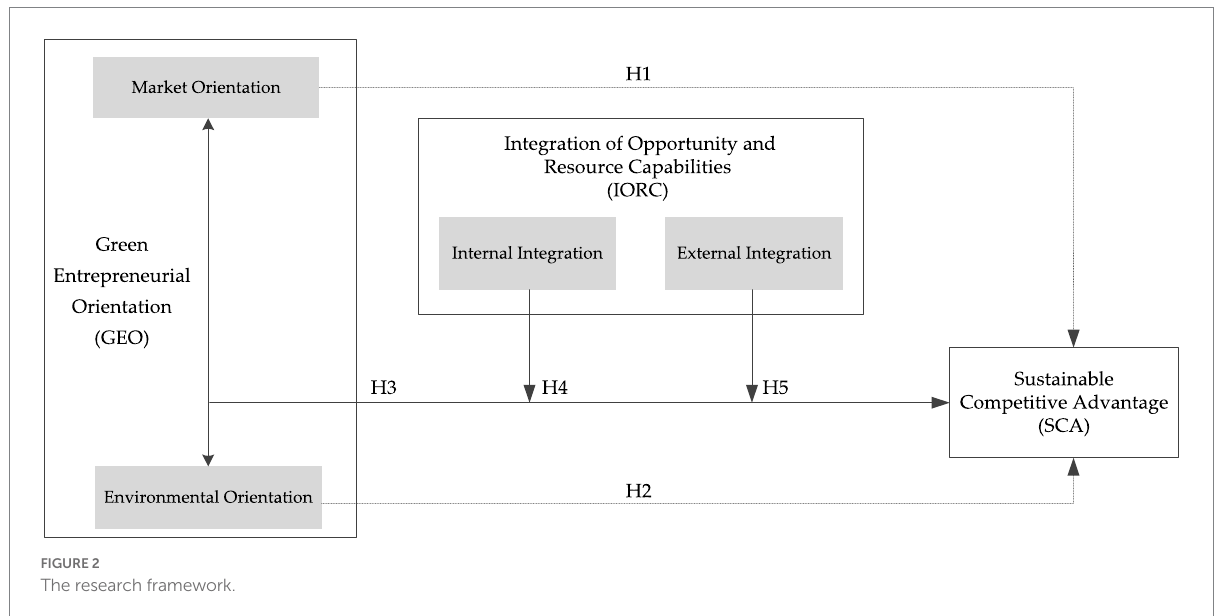
FIGURE 2 The research